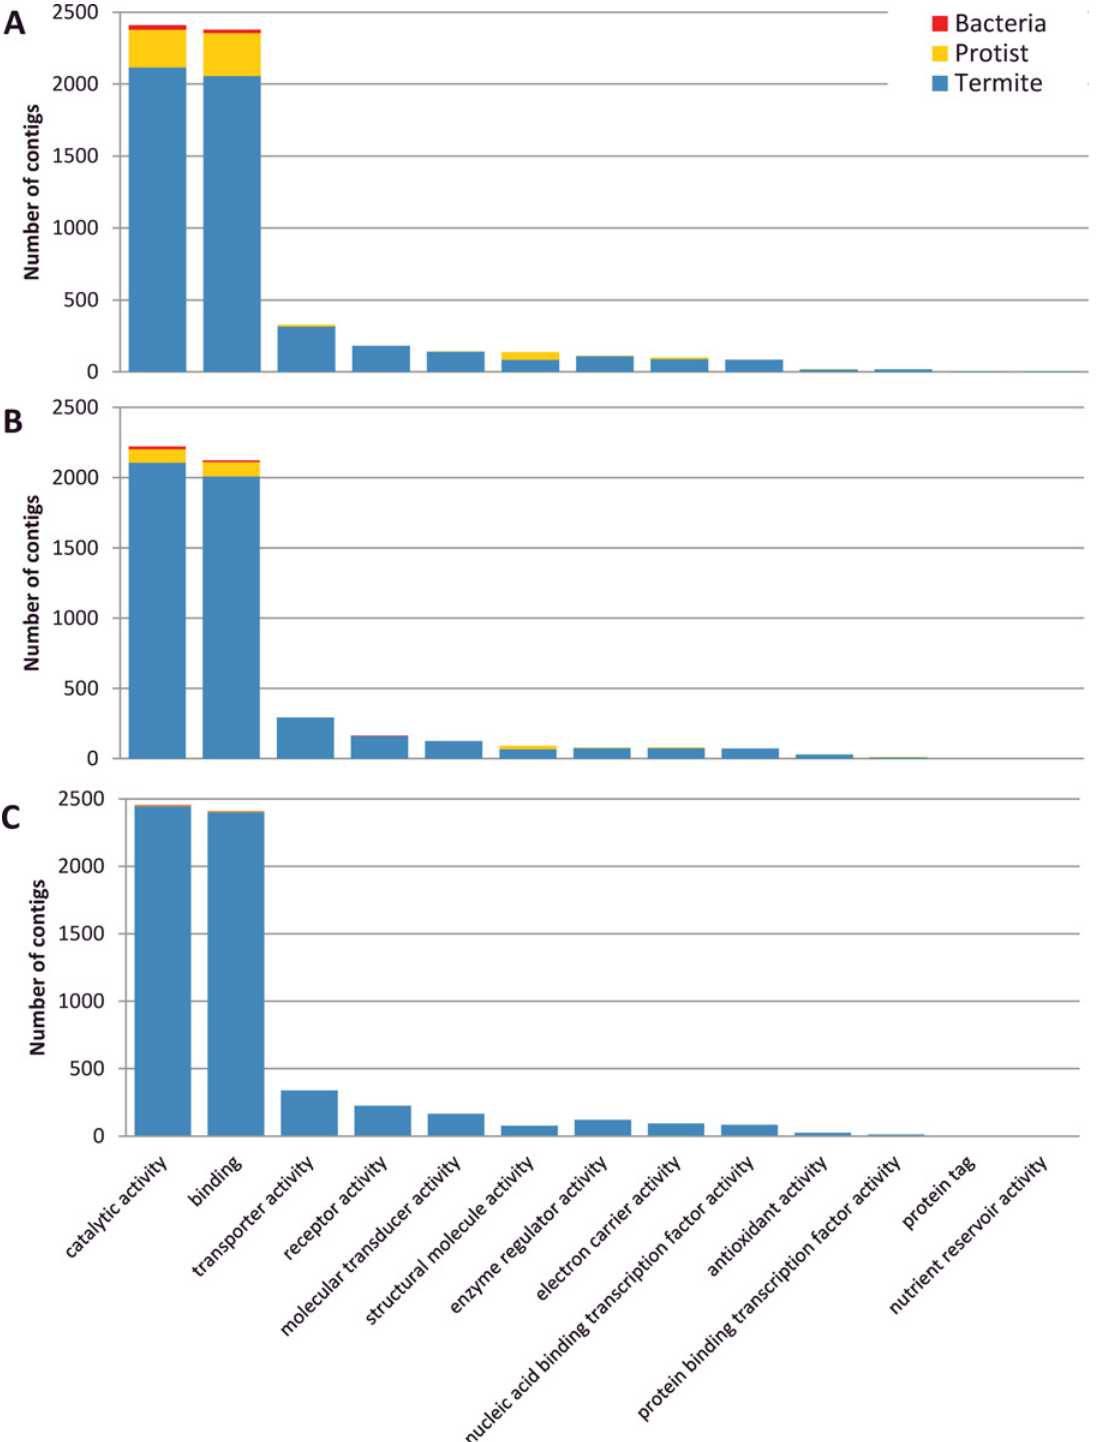
Fig 4. Gene Ontology analysis of Molecular Functions (GO level 2). A: R . flavipes . B: R . grassei , C: R . lucifugus .